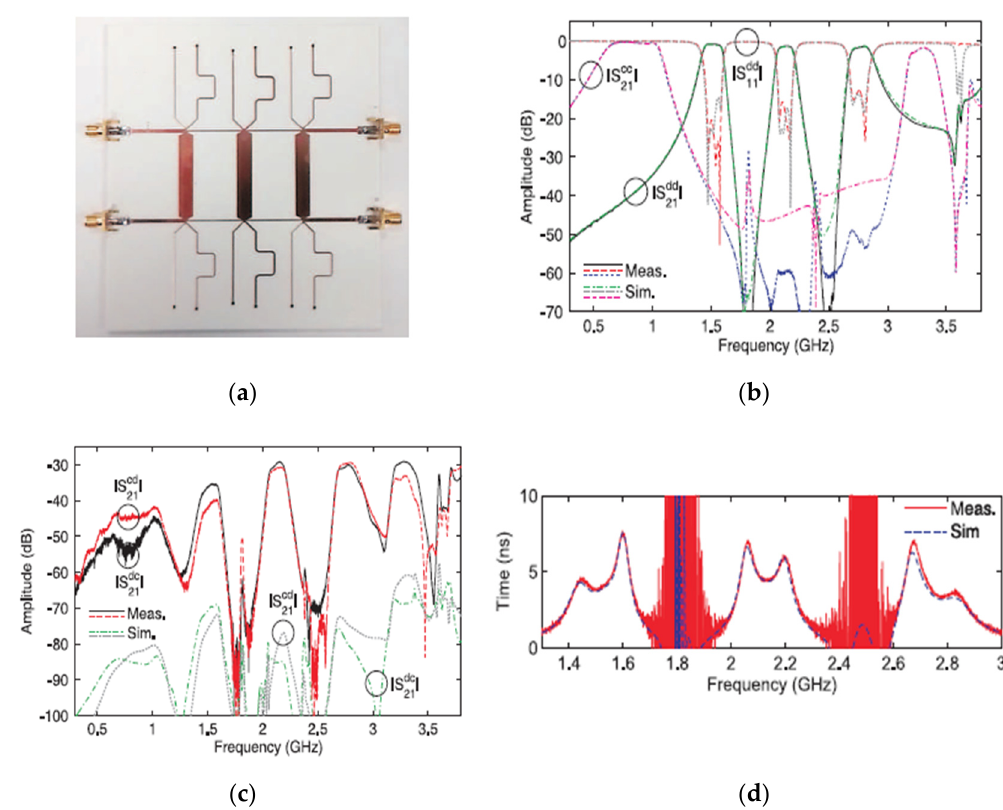
Figure 14. The proposed balanced tri-band BPF [73]: ( a ) Photograph of the fabricated prototype; ( b ) Differential-mode performance; ( c ) Common-mode performance; ( d ) Group delay.